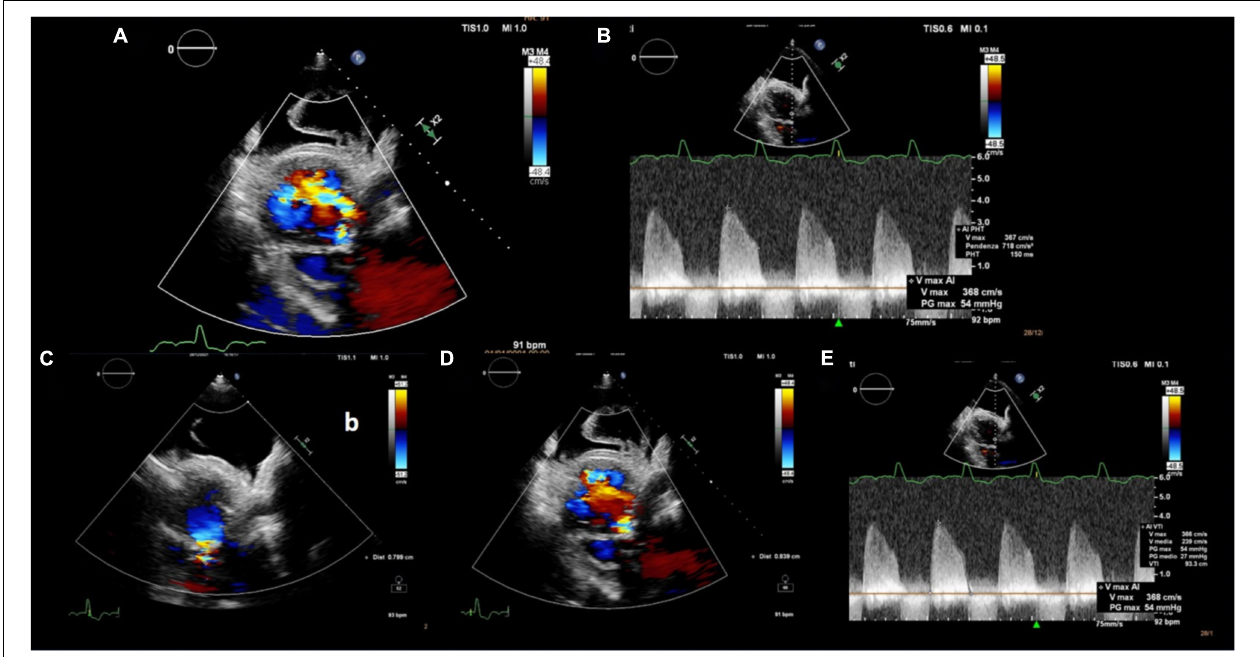
FIGURE 3 | Multiparametric evaluation of aortic regurgitation severity: (A) Wide color flow regurgitant jet area, (B) PHT 150 ms, (C) PISA radius 8 mm, (D) vena contracta 8 mm, and (E) aortic regurgitation VTI 93 cm and Vmax 3.7 cm/s resulting in an EROA 0.52 cm 2 and regurgitant volume 50 ml. PHT: pressure half time; PISA: proximal isovelocity surface area; VTI: velocity time integral; EROA: effective regurgitant orifice area.